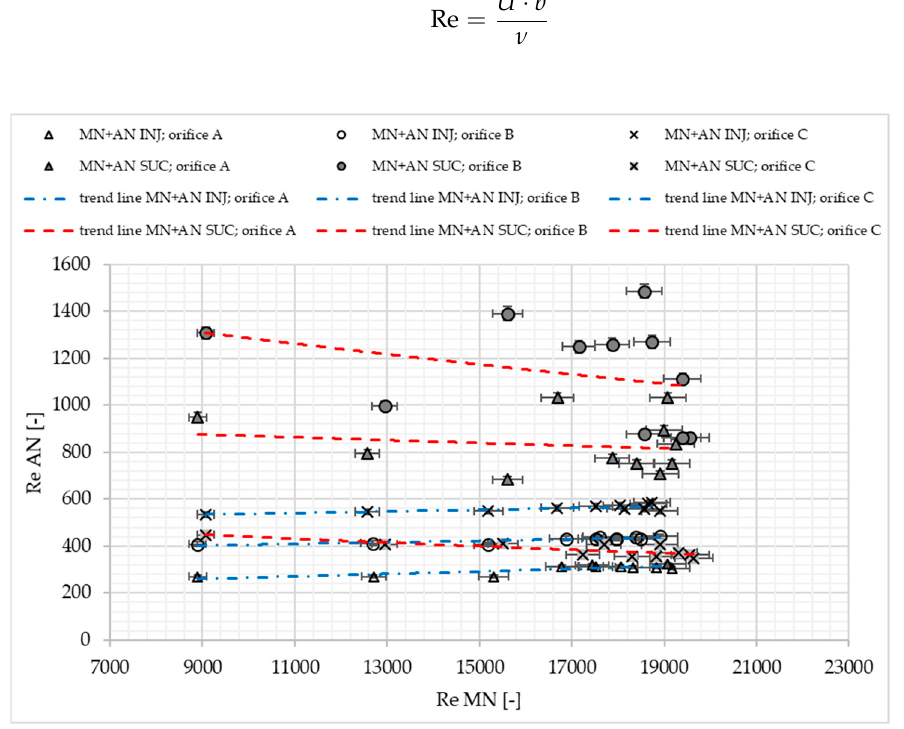
Figure 5. Reynolds number dependence of flow in a system comprising the main supply nozzle (MN) and an auxiliary nozzle (AN) operating as an injection (INJ) or a suction (SUC) nozzle. The Reynolds number ranged from around 16,500 to around 19,600 in the MN. Three orifice plates (A, B and C) were applied to obtain different injection and suction flow rates in the AN. Despite the fact that the operating parameters of the MN and AN were kept constant during the experiment, the ratio of the Reynolds number of the auxiliary jet to the Reynolds number of the main jet ranged from 1.6% to 5.9% (average of around 2.7%) when the AN was operated as an injection nozzle, and it ranged from 1.8% to 14.4% (av ‐ erage of 5.0%) when the AN was operated as a suction nozzle. These differences resulted from the mutual interactions between the main jet and the auxiliary jet. The auxiliary jet was reduced to a minimum to maximize the energy efficiency of the proposed solution. The influence of auxiliary injection and suction jets on the parameters of the main jet was analyzed. The distribution of velocity and turbulence was determined